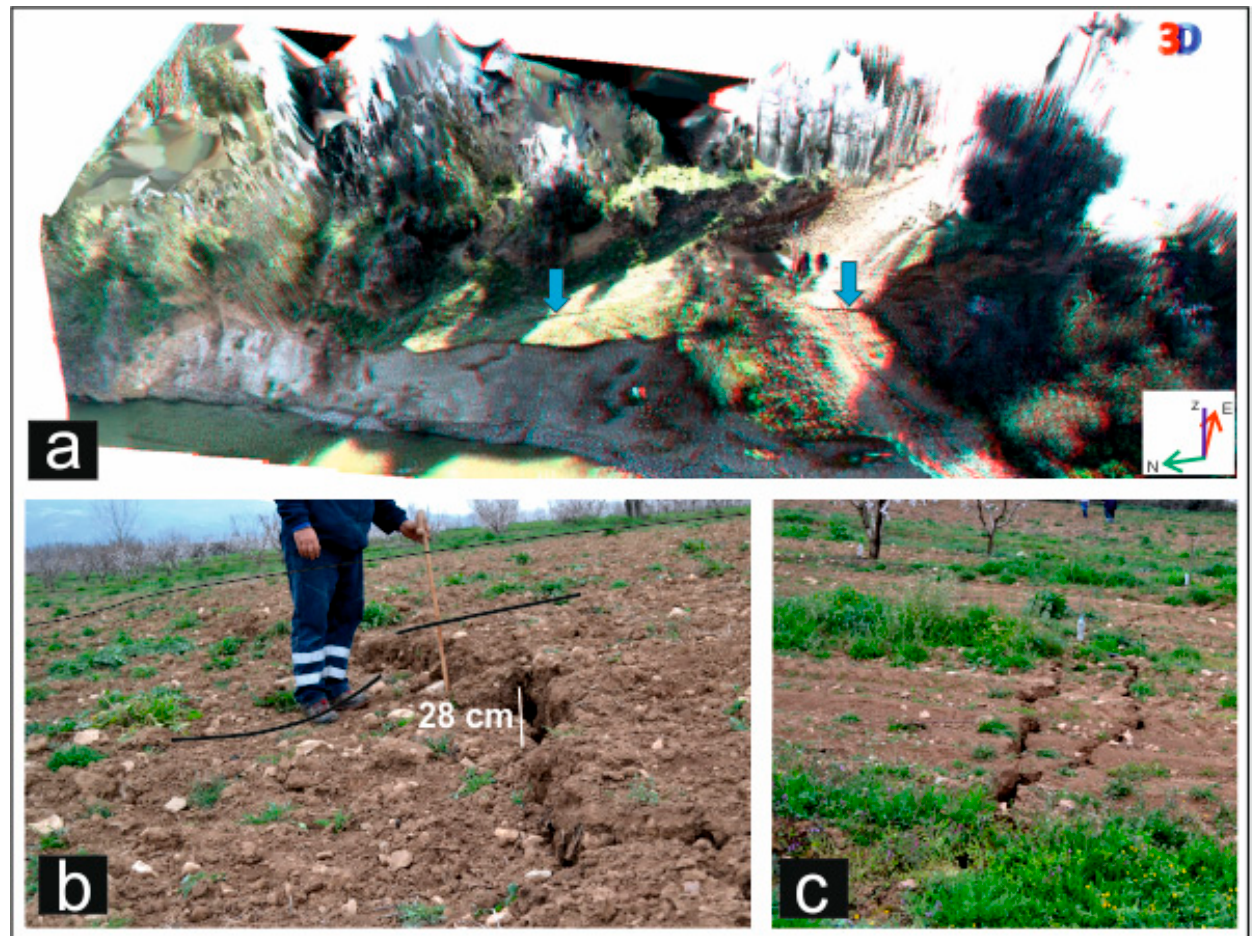
Figure 9. ( a ) A 3D overview of coseismic rupture along MF. Blue arrows show rupture trace represented in ( b , c ) along flexural fault scarp. Photo ( b ) is taken looking west, and surface offset is 28 cm. In this area, we excavated the palaeoseismological trench MeTr1. Photo ( c ) is taken looking east and shows MF flexural scarp with major and secondary coseismic ruptures.